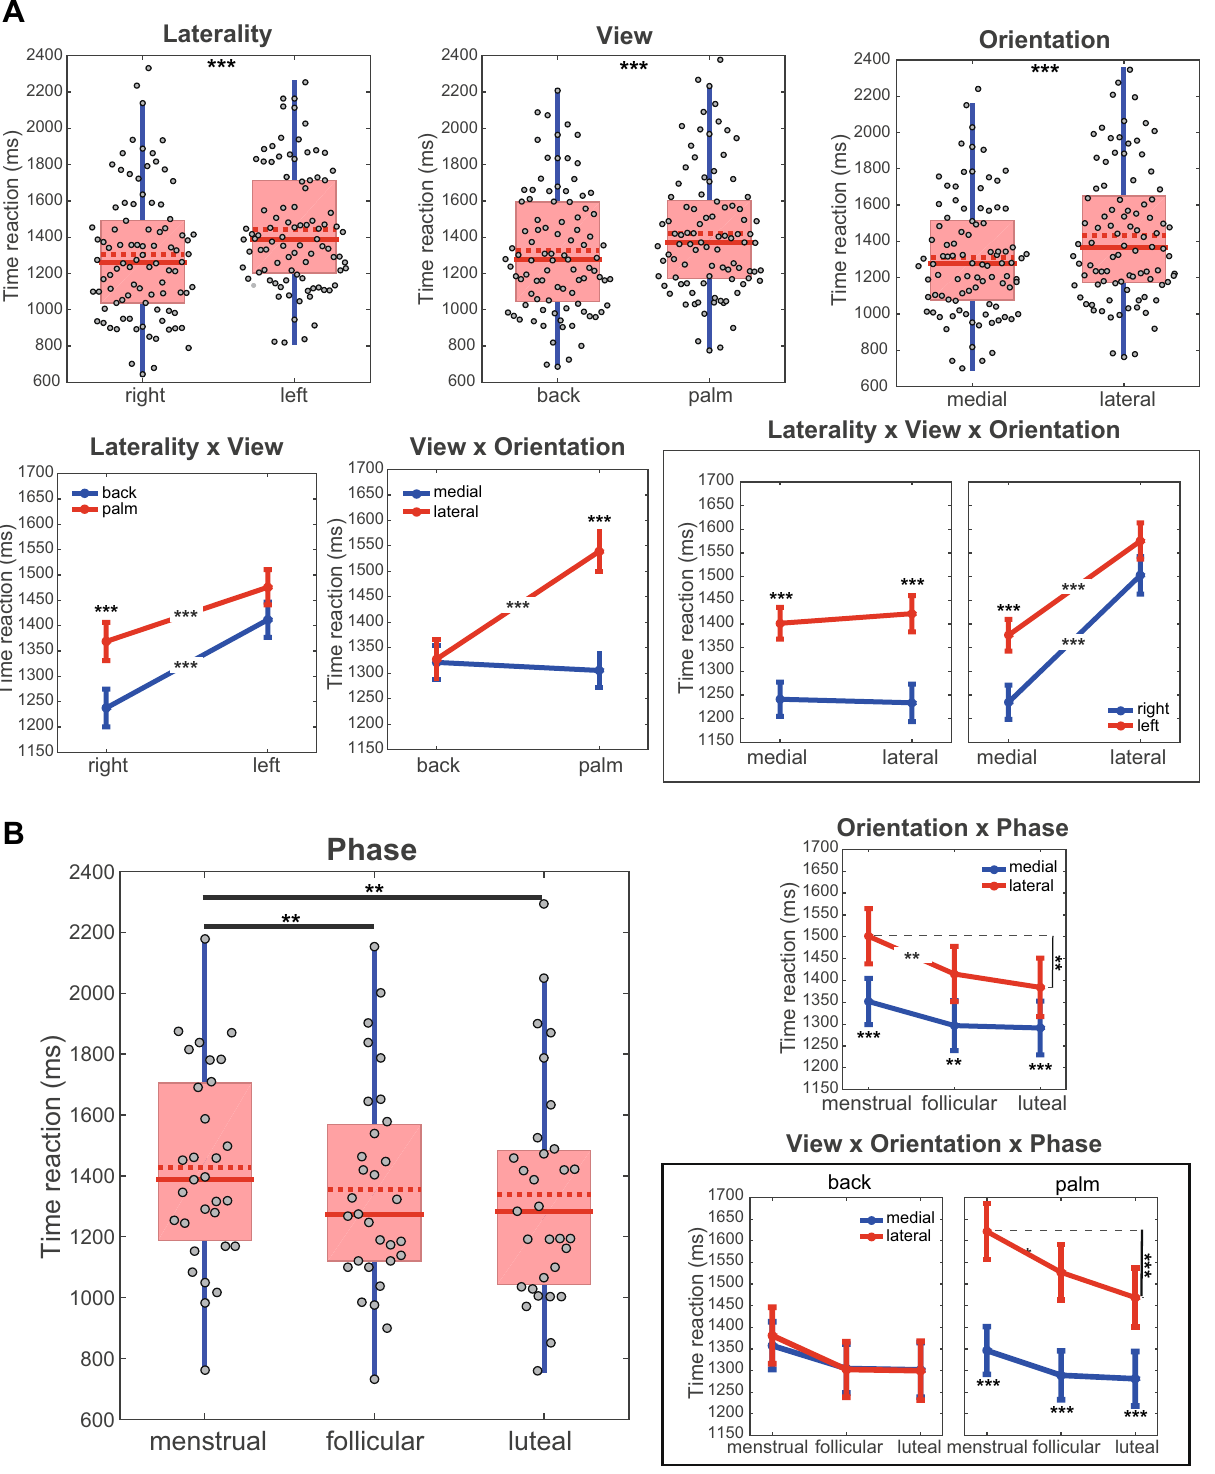
Figure 5. Interactions and main effects for reaction time. ( A ) Effect of hand features on the reaction time. ( B ) Effect of menstrual cycle and interaction between menstrual cycle and hand features on the reaction time. The main effects are presented in a boxplot. The filled red line in the boxplot represents the median and the dotted red line represents the mean. The interactions are presented in the form of mean and standard error. P -value: < 0.001 (***), < 0.01 (**), < 0.05 (*); Bonferroni correction for post-hoc